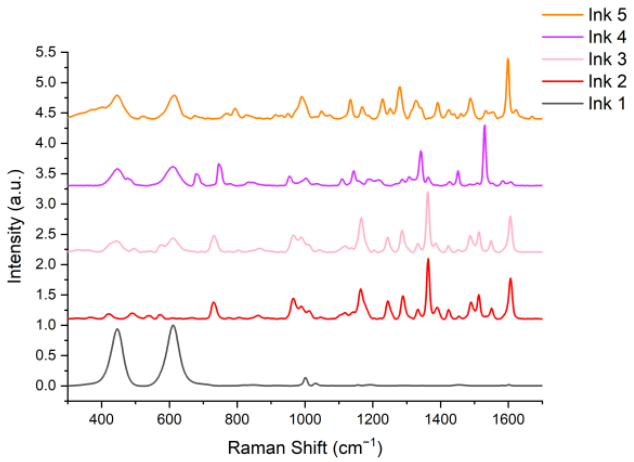
Figure 3. Pre-processed Raman spectra of Inks 1–5. In Ink 1 (white), the color is caused by titanium oxide, characterized by bands at 450 and 610 cm − 1 . These bands are also visible in the spectra of Inks 2, 4, and 5, where titanium oxide was used to obtain brighter colors by enhancing the phenomenon of light scattering (pink, bright orange). Due to the presence of pigments with a similar chemical structure in Inks 2 and 3 (C.I.12477, C.I.12475), their spectra have a similar shape but their characteristic bands are shifted relative to each other: 862, 1047, 1142, and 1289 cm − 1 for Ink 2, and 668, 1043, 1138, and 1285 cm − 1 for Ink 3 [29,30]. Inks 2 and 4 share the same pigment (C.I.12475), and thus, these bands can also be seen in Ink 4 yet at a much lower intensity. This pigment is responsible for red, which is a primary color in Ink 2, while it only gives a secondary color impression in Ink 4 (violet). In most of the spectra, one can see the bands characteristic of additives such as glycerin (1040 and 1490 cm − 1 ), isopropanol (1450 cm − 1 ), and benzyl alcohol, (800 and 1000 cm − 1 ). A table listing the characteristic bands of Inks 1–5 can be found in the Supplementary Materials. The table in the Supple- mentary Materials (SM) provides the association between the found Raman bands of